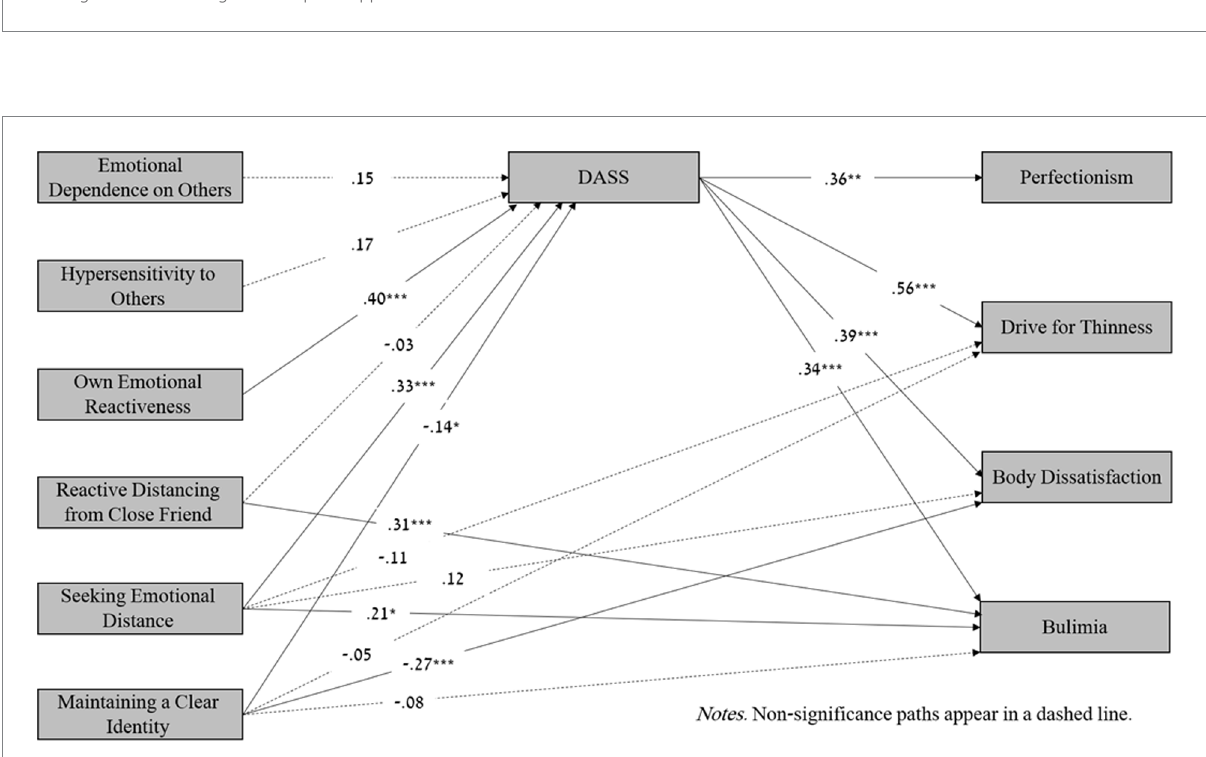
FIGURE 2 Mediation model: The associations between differentiation of self and risk of eating disorders mediated by depression, anxiety and stress (DASS) among males. Non-Significance paths appear in a dashed